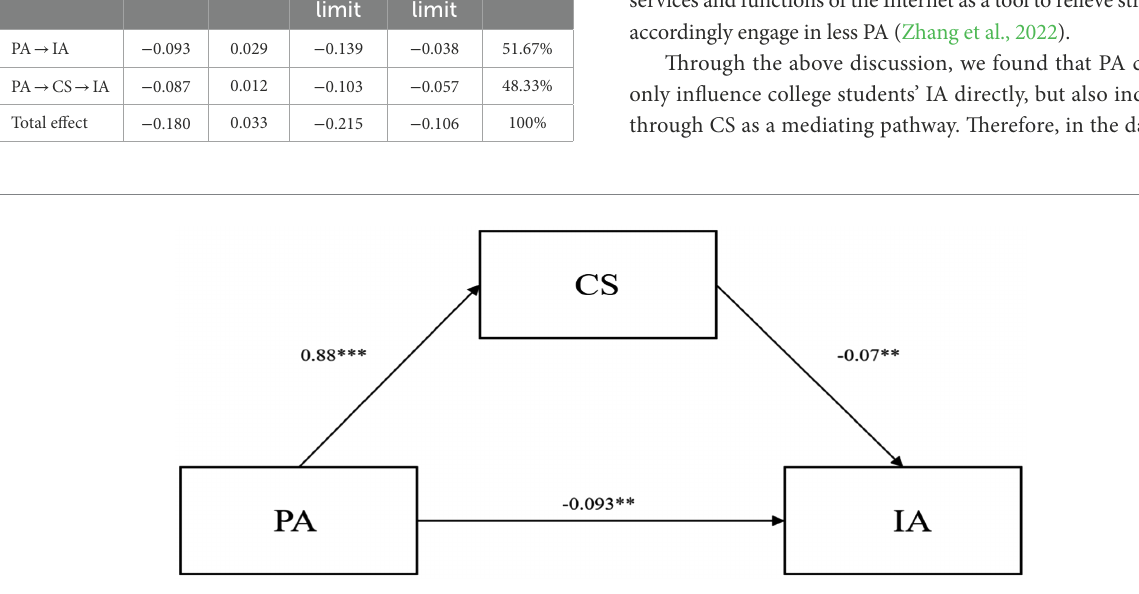
FIGURE 2 Diagram of the CS mediation model. ** p < 0.01; *** p <